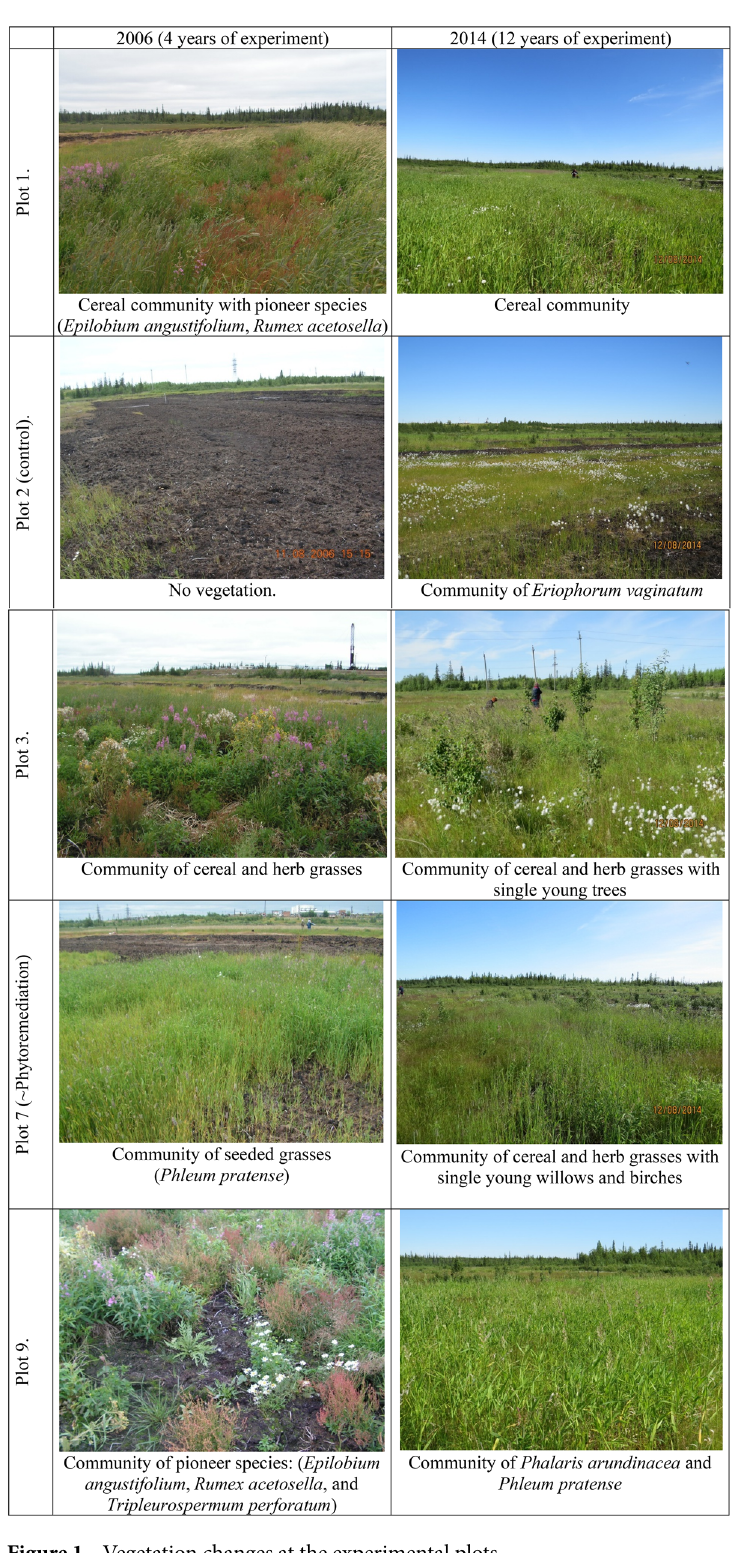
Figure 1. Vegetation changes at the experimental